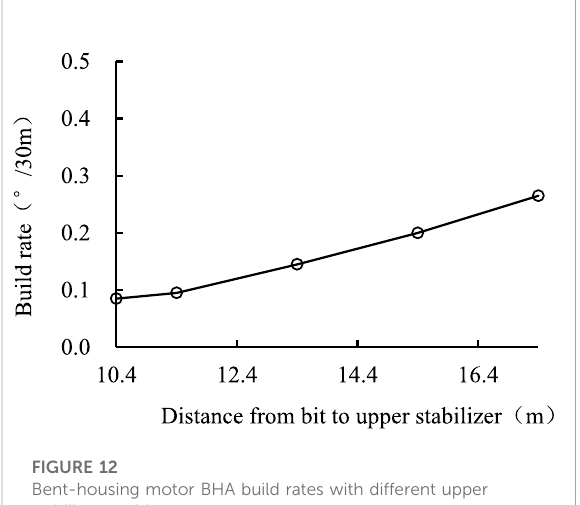
FIGURE 12 Bent-housing motor BHA build rates with different upper stabilizer position.